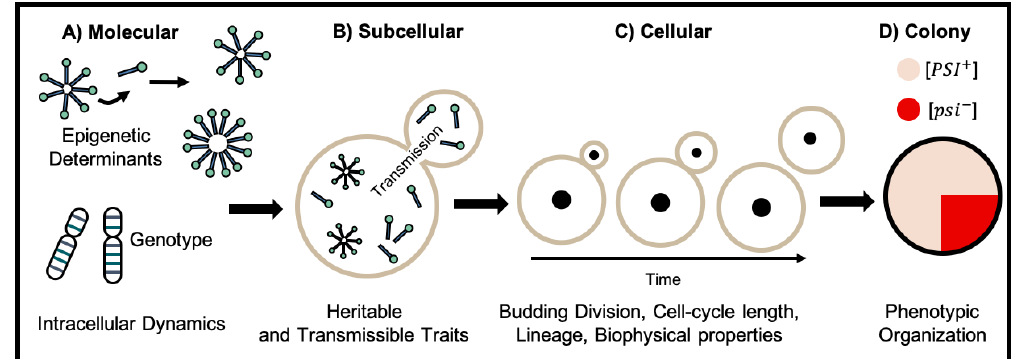
Figure 1. Spatial Phenotypes are the Consequence of Processes at Different Scales. ( A ) Cells transition between different phenotypic states due to genetic mutations or epigenetic determinants. For example, alternative conformations of the prion protein in S. cerevisiae can function as epigenetic determinants of transmissible phenotypes. ( B ) Daughter cells inherit their phenotype from their mother. In some cases, inefficient transmission of different intracellular constituents (i.e., prion aggregates) can lead to loss of phenotype. ( C ) Individual cell behaviors impact the propagation, loss and spatial arrangement of phenotypes within the colony. In this paper we investigate the impact of budding division in S. cerevisiae on overall shape, size and spatial organization of cells. During budding division, the new daughter cell forms as a bud on the mother cell and remains attached until it reaches a mature size and they physically separate. ( D ) The outcome of processes at the molecular, subcellular and cellular scales lead to different morphological traits such as sector-like regions in S. cerevisiae colonies where all cells have lost the prion